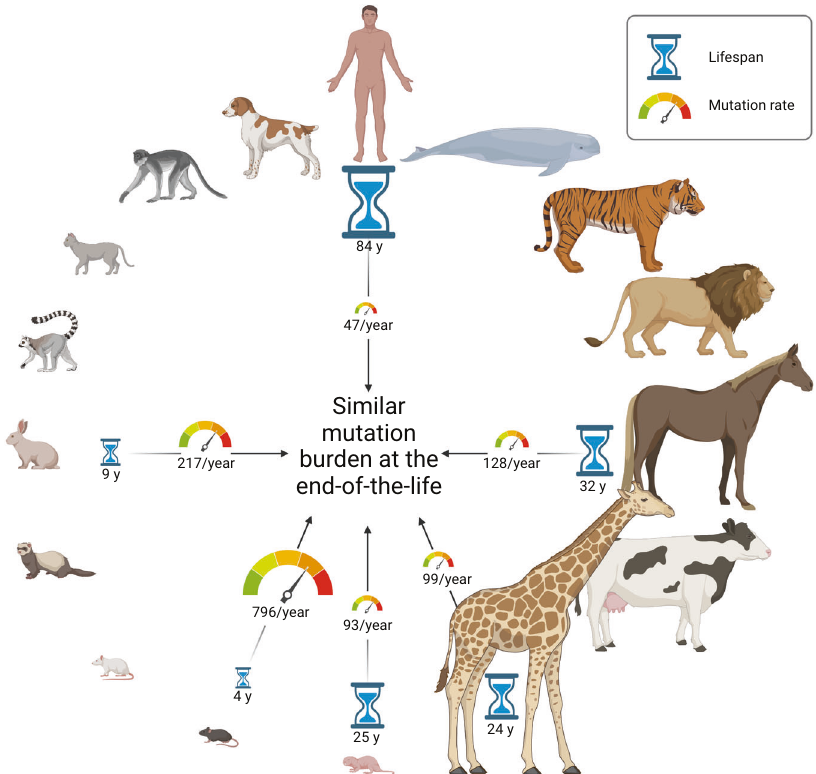
Fig. 1 Mutation rate is inversely correlated with lifespan. Cagan et al. 1 demonstrate by comparative whole-genome sequencing of clonal colon crypts that the mutational rate of somatic mutations (tachometer) is inversely correlated with the lifespan (hourglass) in mammals across 16 different species. However, the mutation burden at the end of life is highly similar among these species. This observation is largely independent from the respective body mass. The fi gure was generated with